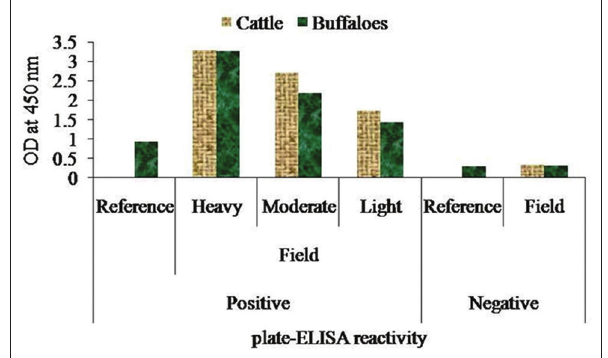
Figure-4: Plate enzyme-linked immunosorbent assay reactivity pattern of Fasciola gigantica